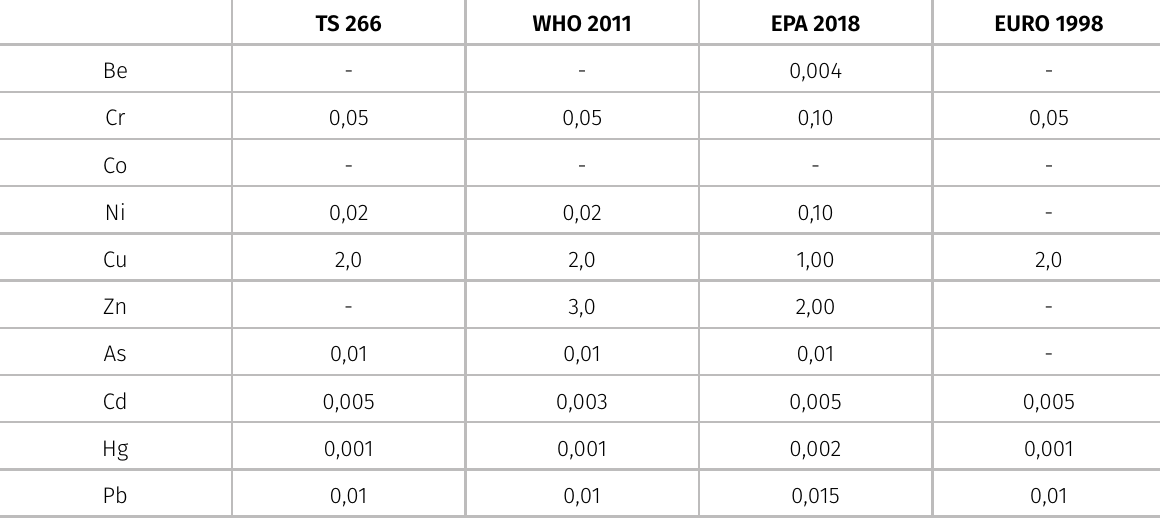
Table V. Trace element limit values according to standards (mg /